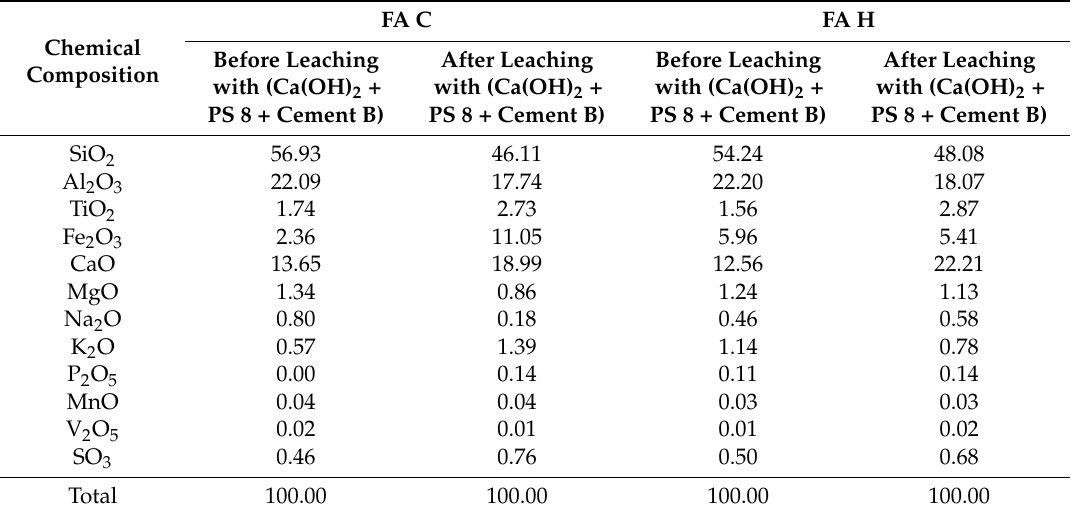
Table 4. Chemical composition of the coal fly ashes and Ca(OH) 2 , PS ash 8 and BF cement mixtures before and after